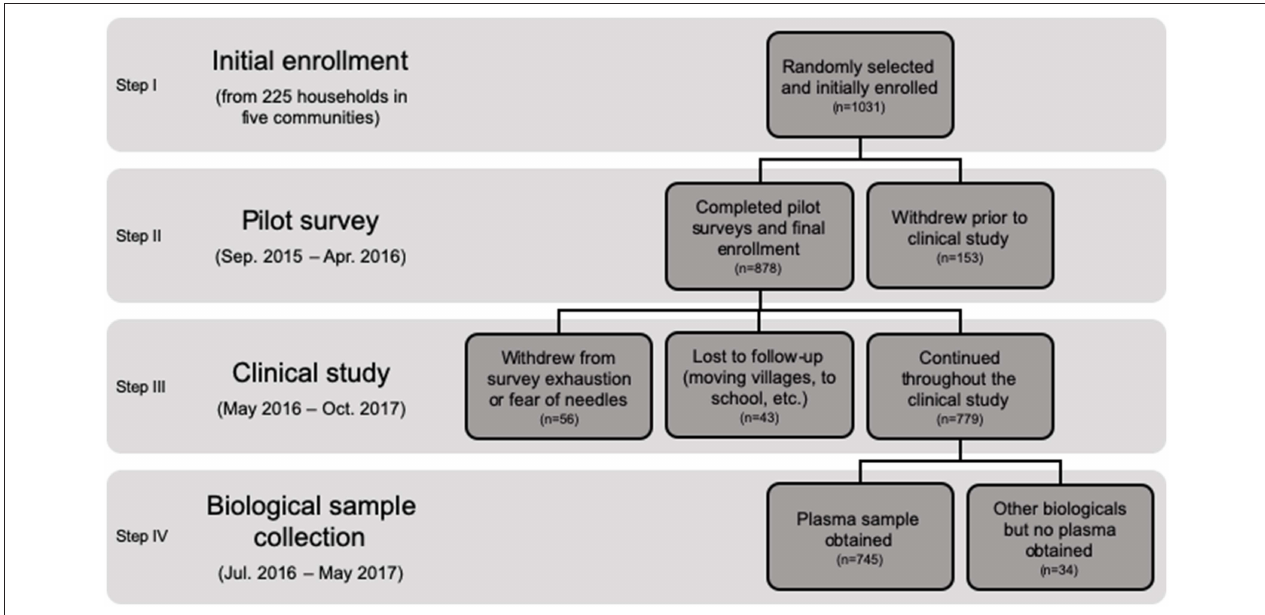
FIGURE 1 | Consort figure of the MAHERY-Antongil study